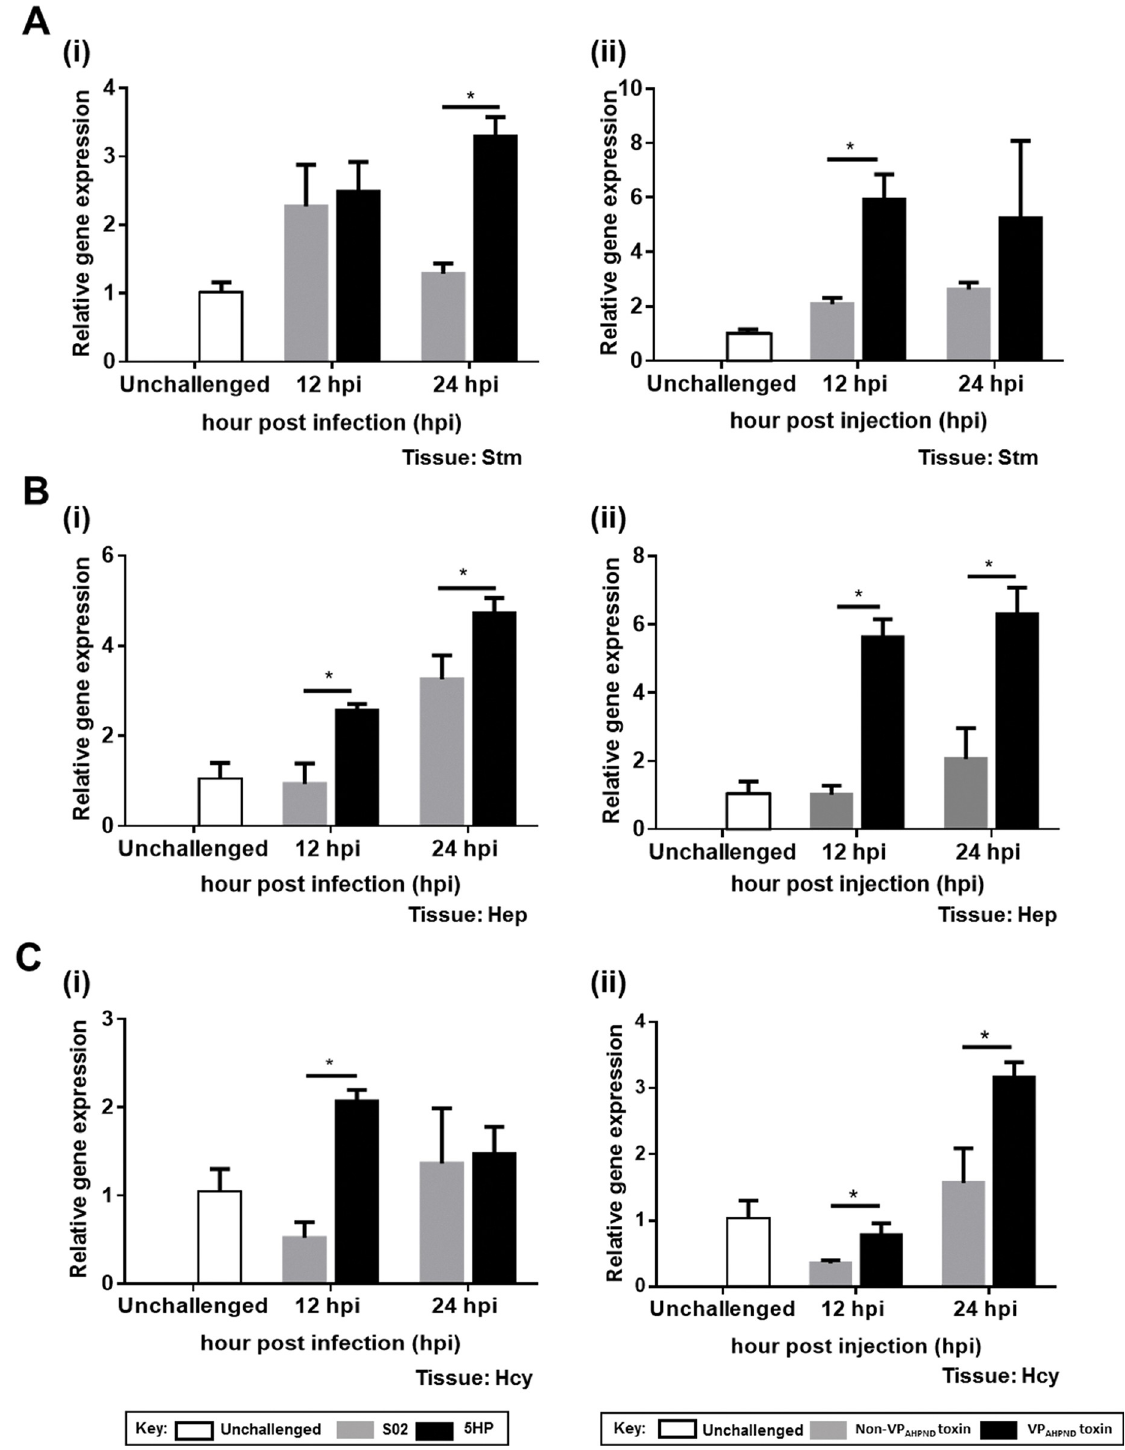
Fig 2. Expression of the Lv APN1 gene upon VP AHPND and VP AHPND toxin challenges. (A) Stomach, (B) hepatopancreas, and (C) hemocyte of L . vannamei were collected before infection (unchallenged) and after challenge with 5HP (i) or the partially purified VP AHPND toxins (ii) at 12 and 24 h. Lv APN1 expression was analyzed by qRT-PCR using EF-1 α as the internal control gene. The data represent fold change of Lv APN1 expression in the 5HP or VP AHPND producing strain challenged group compared to the S02 or non-VP AHPND toxin producing strain-challenge control. The experiments were done in triplicate. Each bar represents the mean ± standard deviation (SD). Asterisks indicate significant difference ( P < 0.05). https://doi.org/10.1371/journal.ppat.1009463.g002 PLOS Pathogens| https://doi.org/10.1371/journal.ppat.1009463 March 26,